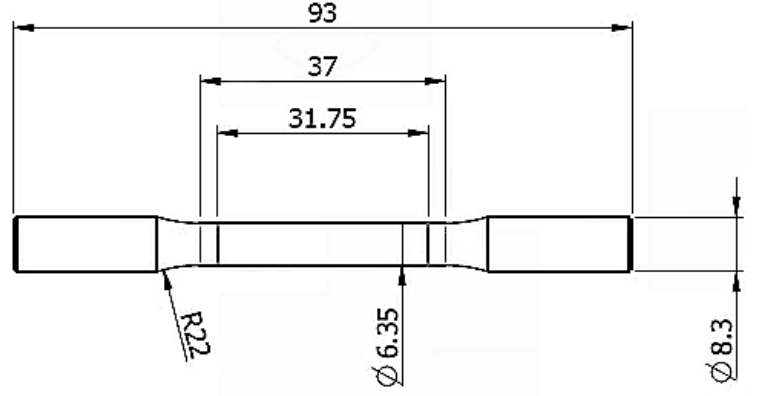
Figure 1. Geometry of the NM (non-machined) tensile specimen. Density was measured by using a hydrostatic balance (Gibitre Instruments, Electronic Densimeter Resol2.0) based on the Archimedes method. The density (g/cm 3 ) is